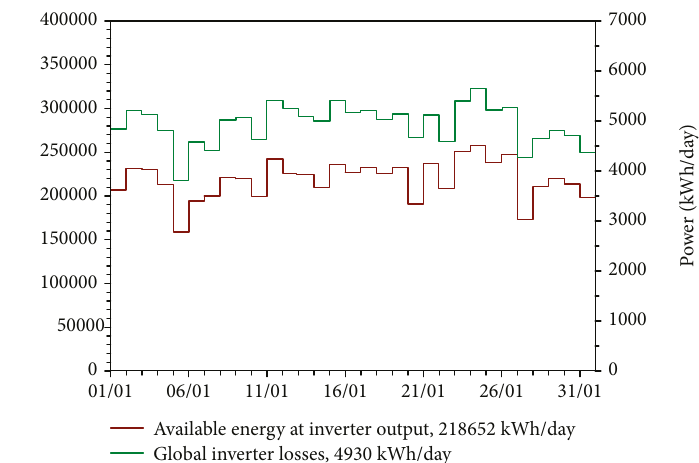
Figure 7: First month of global inverter loss and available energy at inverter